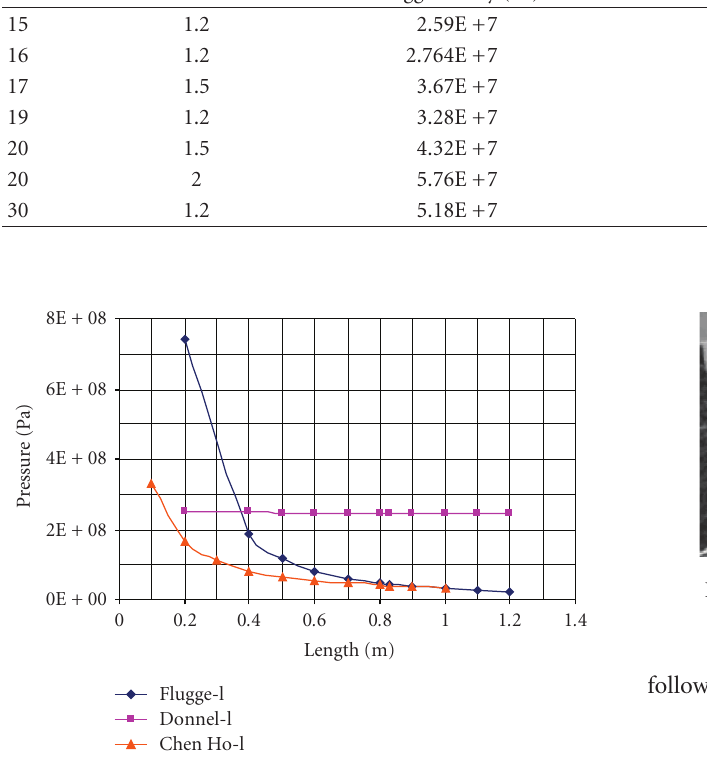
Figure 1: Linear analyses pressure results comparison.